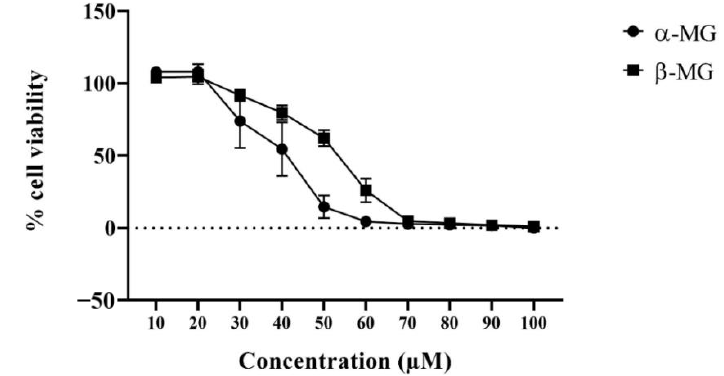
Figure 3. The percent of cell viability treated with the variation of α -MG and β -MG. ( n = 3).